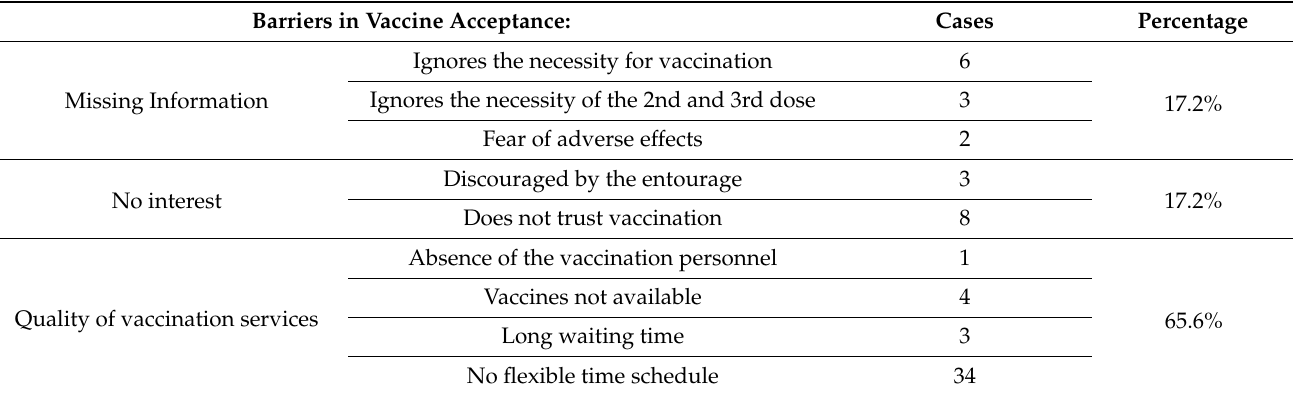
Table 2. Given reasons by parents for missing the EPI ( n = 64).